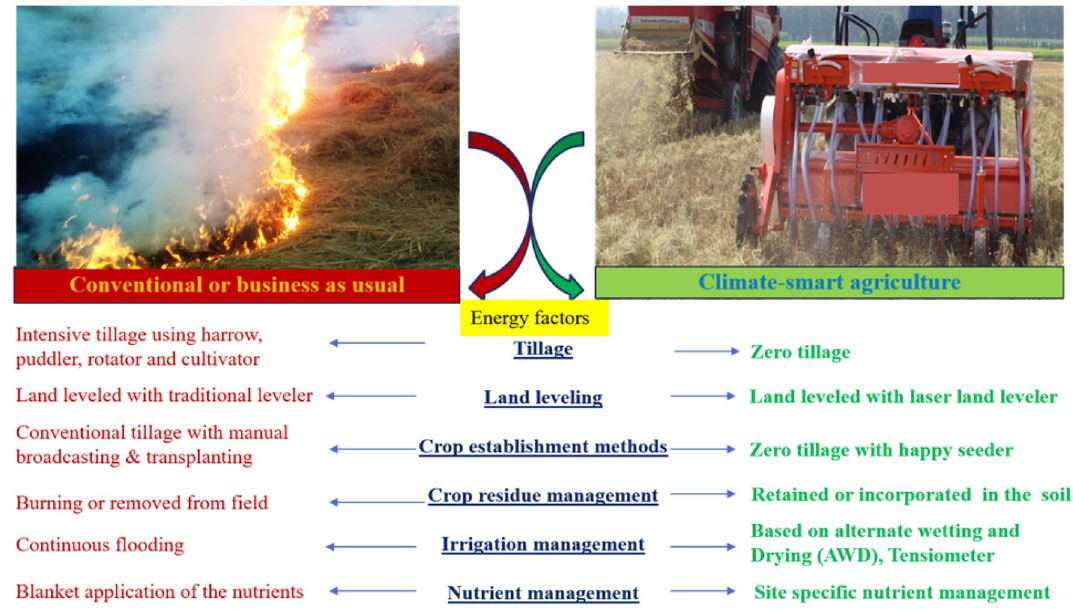
Figure 7. Energy sources of RW production under conventional management practice (left) and climate-smart agricultural practices